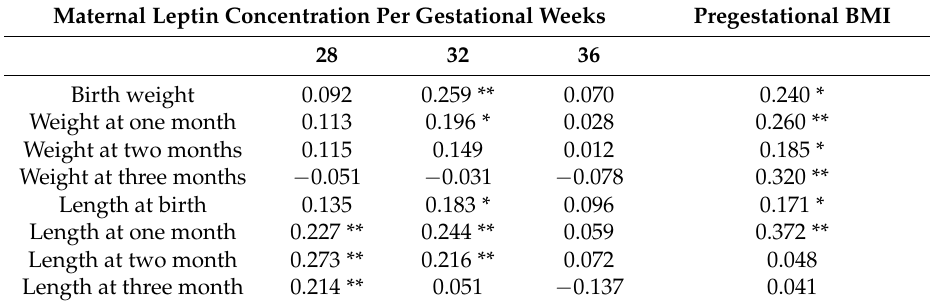
Table 2. Correlations of maternal leptin concentrations and pregestational BMI with neonatal outcomes. Maternal Leptin Concentration Per Gestational Weeks Pregestational